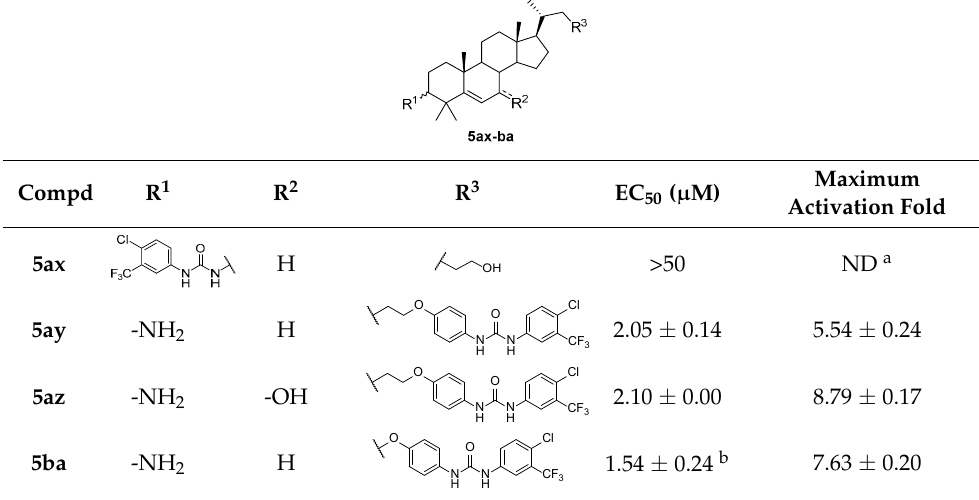
Table 5. Anti-tumor effects of compounds 5az-ba .